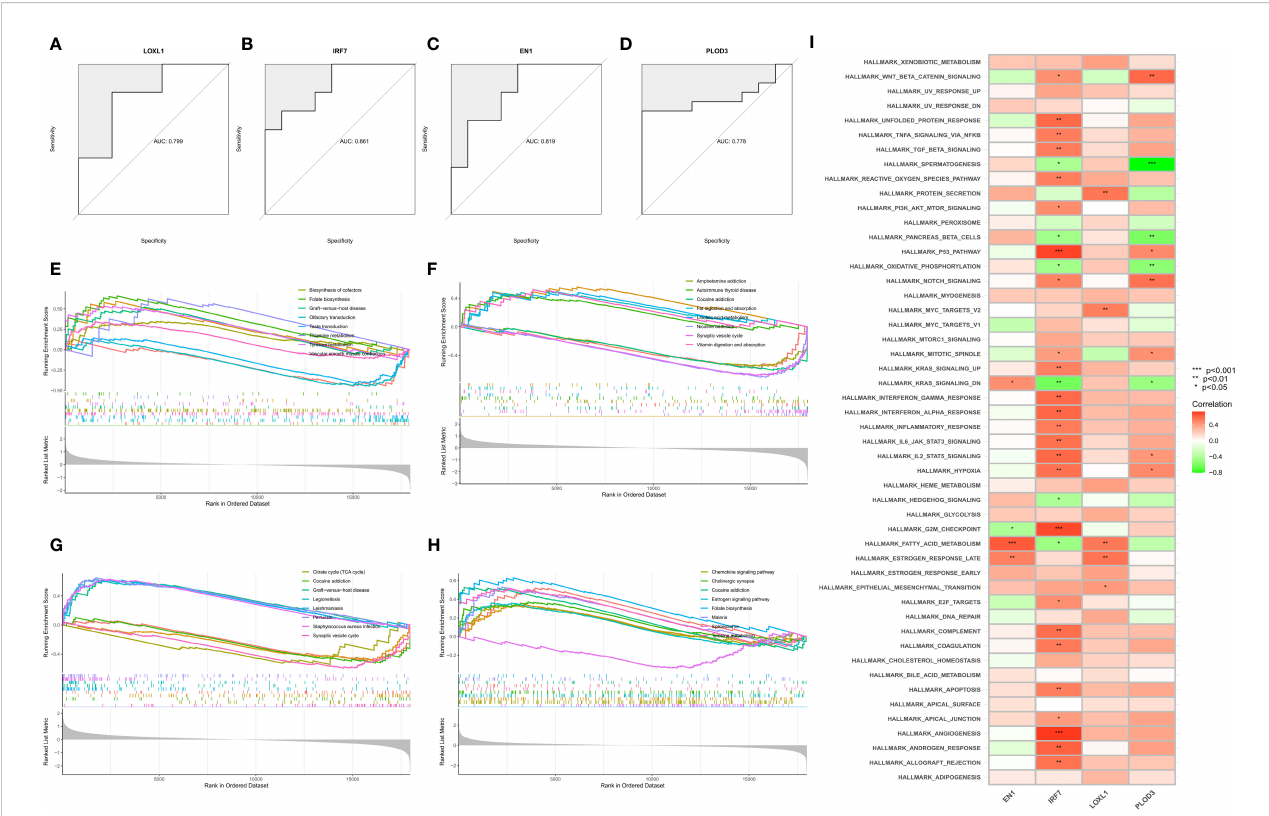
FIGURE 5 Construction, diagnostic ef fi cacy, and enrichment analysis of histograms of characteristic NFRGs. (A – D) ROC curves for calculating the signature genes ’ diagnostic performance. (E – H) The main signaling pathways associated with speci fi c genes identi fi ed using GSEA. (I) Correlation of signature genes with pathways using GSVA